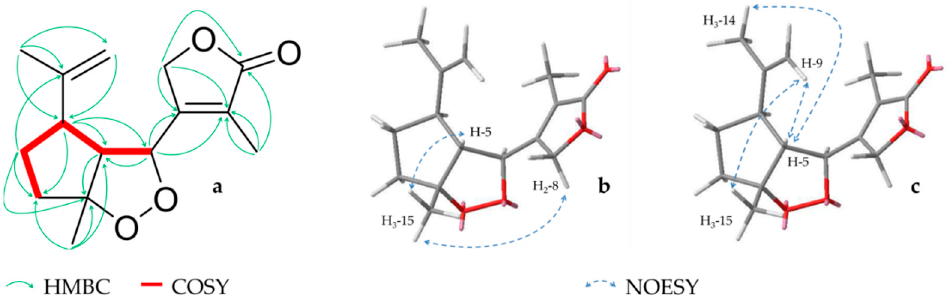
Figure 3. Key HMBC, COSY ( a ) and NOESY (nuclear Overhauser effect spectroscopy) correlations in the cyclic peroxide ( b ) and the cyclopentane ( c ) for compound 3 .